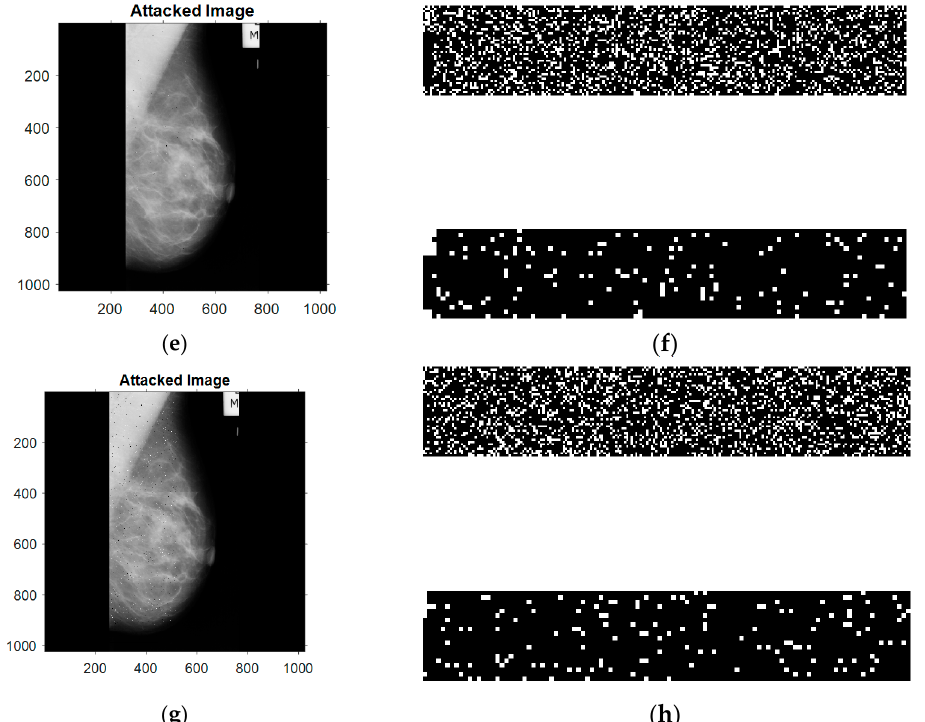
Figure 16. Malicious attack and retrieved identities. ( a ) Attack by altering 25 pixels (0.01%) of the mammogram. ( b ) Corresonging retrieved identity rI and wI ( MSE = 0.33, PSNR = 4.81 and SSIM = 0.17). ( c ) Attack by altering 50 pixels (0.02%) of the mammogram. ( d ) Corresponding retrieved identity rI and wI ( MSE = 0.34, PSNR = 4.75 and SSIM = 0.16). ( e ) Attack by altering 250 pixels (0.1%) of the mammogram. ( f ) Corresponding retrieved identity rI and wI ( MSE = 0.36, PSNR = 4.40 and SSIM = 0.09). ( g ) Attack by altering 2524 pixels (1%) of the mammogram. ( h ) Corresponding retrieved identity rI and wI ( MSE = 0.37, PSNR = 4.26 and SSIM = 0.07).